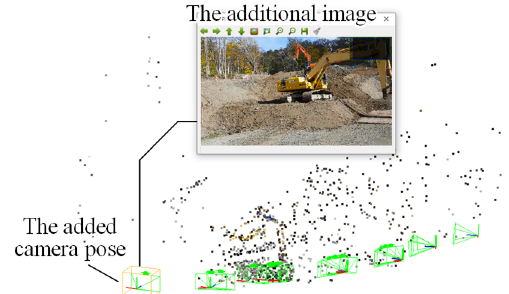
Figure 15. The additional image and the added camera